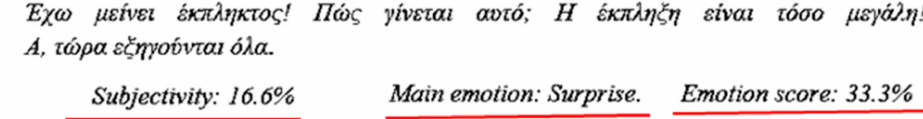
Figure 4. Initial sentiment analyzer module of spaCy (Greek version).